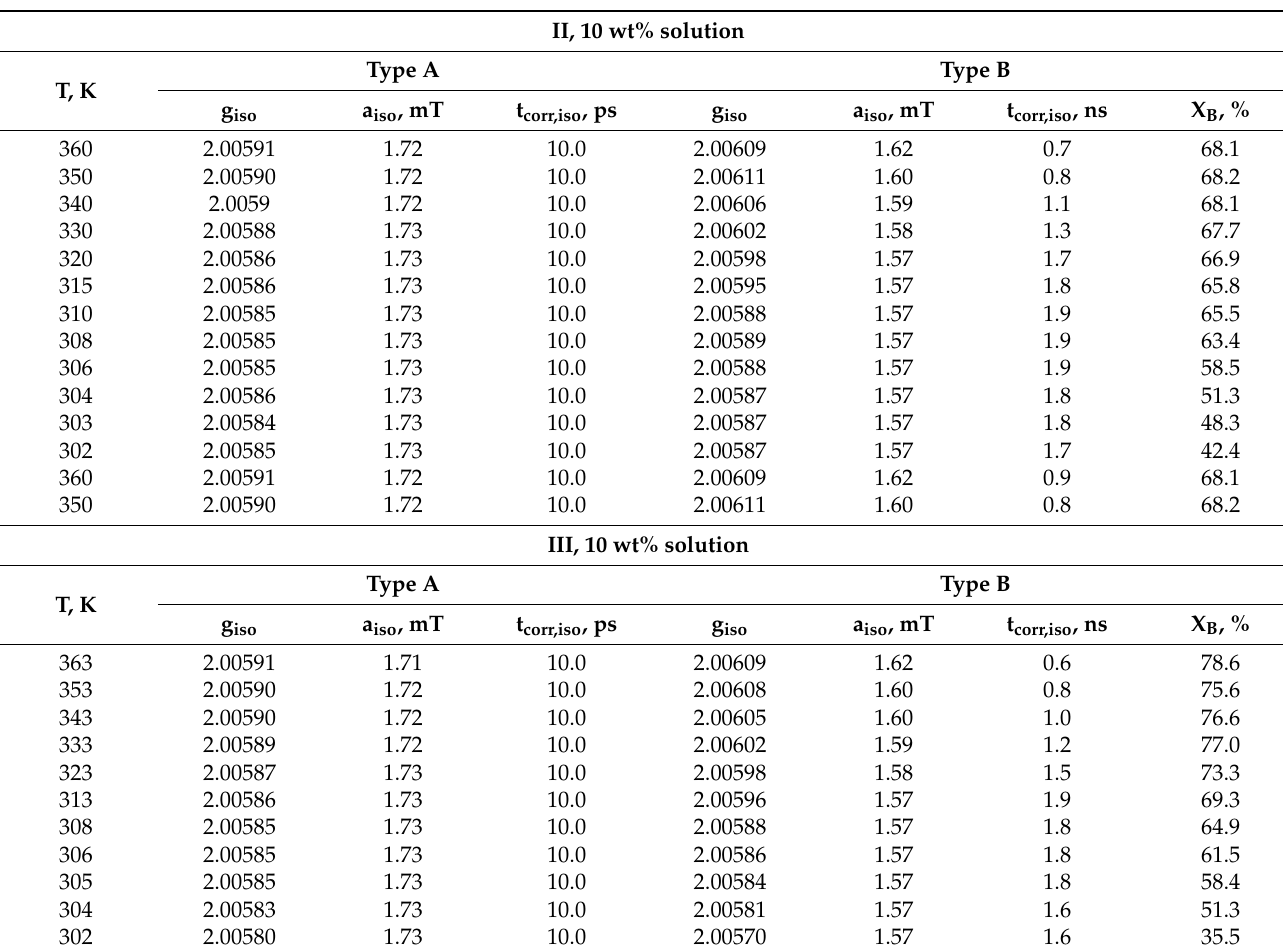
Table A2. Selected spectral parameters from simulation TEMPO EPR spectra in 5 and 10 wt% solutions at 295–363